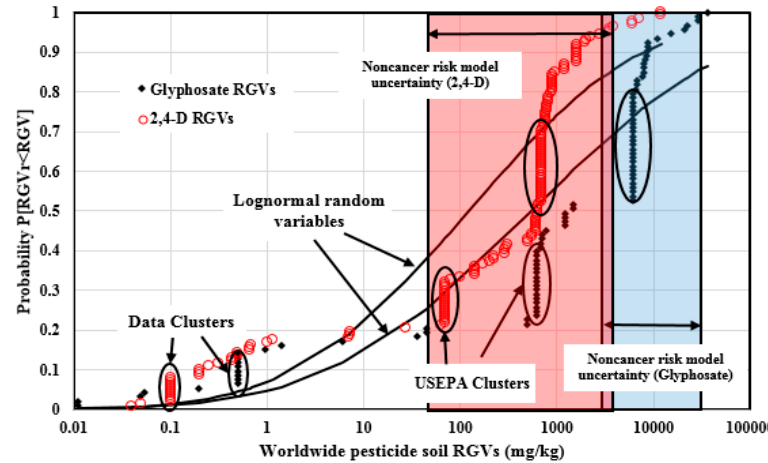
Figure 5. 2,4-D and Glyphosate soil RGVs plotted in the empirical cumulative distribution forms and compared to the log-normal random variable cumulative distributions with identical statistics.